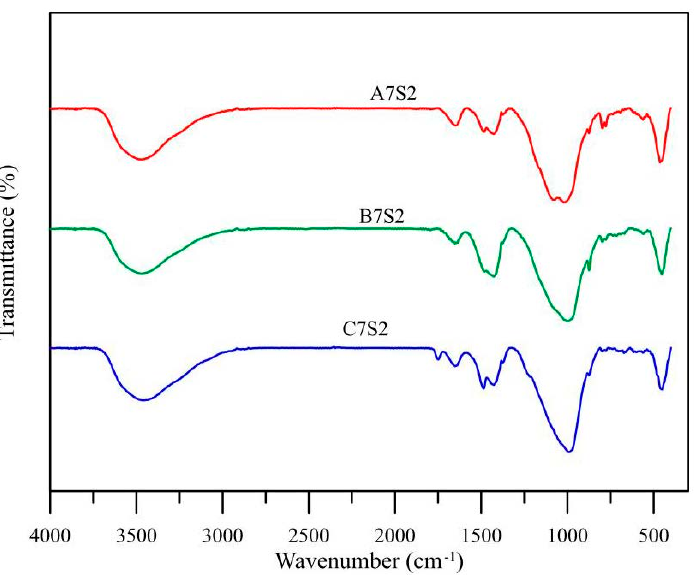
Figure 9. Fourier Transform Infrared Spectroscopy analysis of different fly ash mixtures at alkali equivalent = 7% and 20% GGBFs replacement.